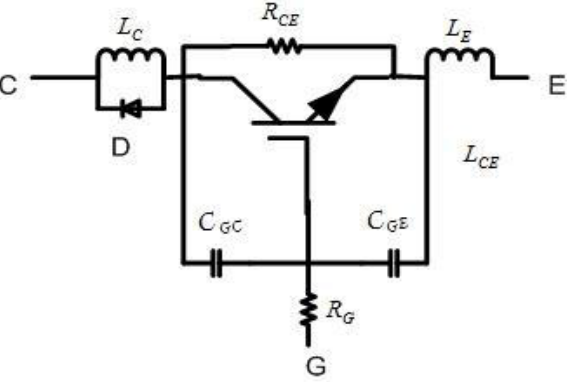
Figure 1. The actual equivalent circuit of a MOSFET.